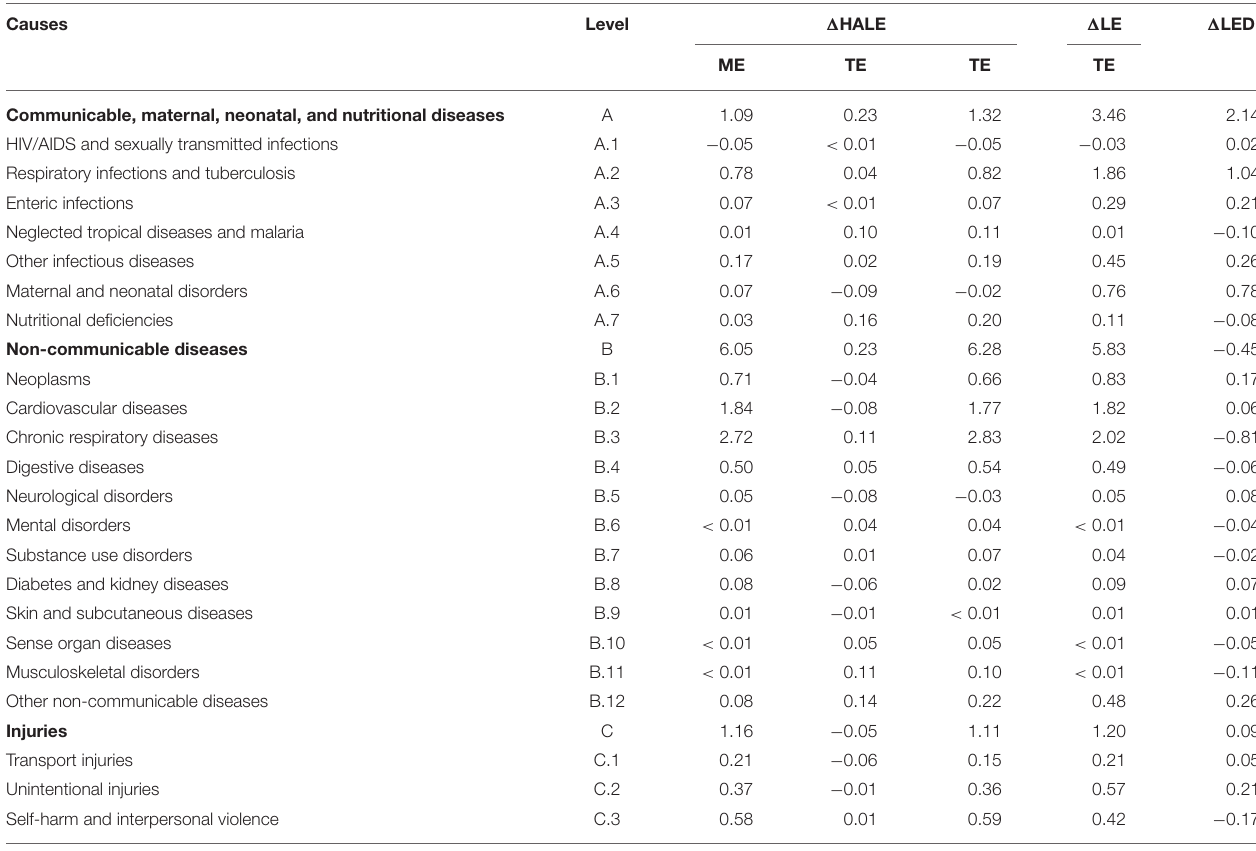
TABLE 3 | Cause-specific effects on changes in life expectancy (LE) and health-adjusted life expectancy (HALE) from 1990 to 2019 (years, levels 1–2).